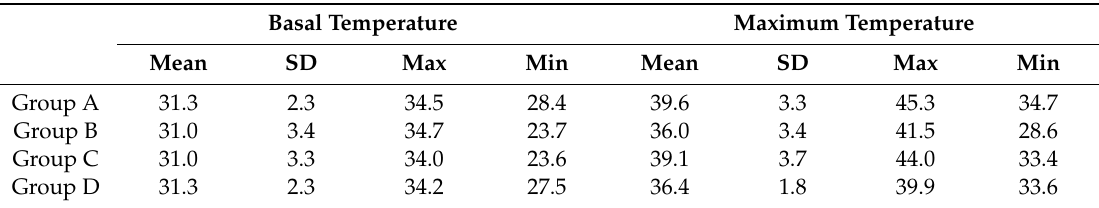
Table 2. Basal temperature and maximum temperature for the di ff erent groups are shown in ◦ C. SD: Standard deviation; Max: maximum value; Min: minimum value.